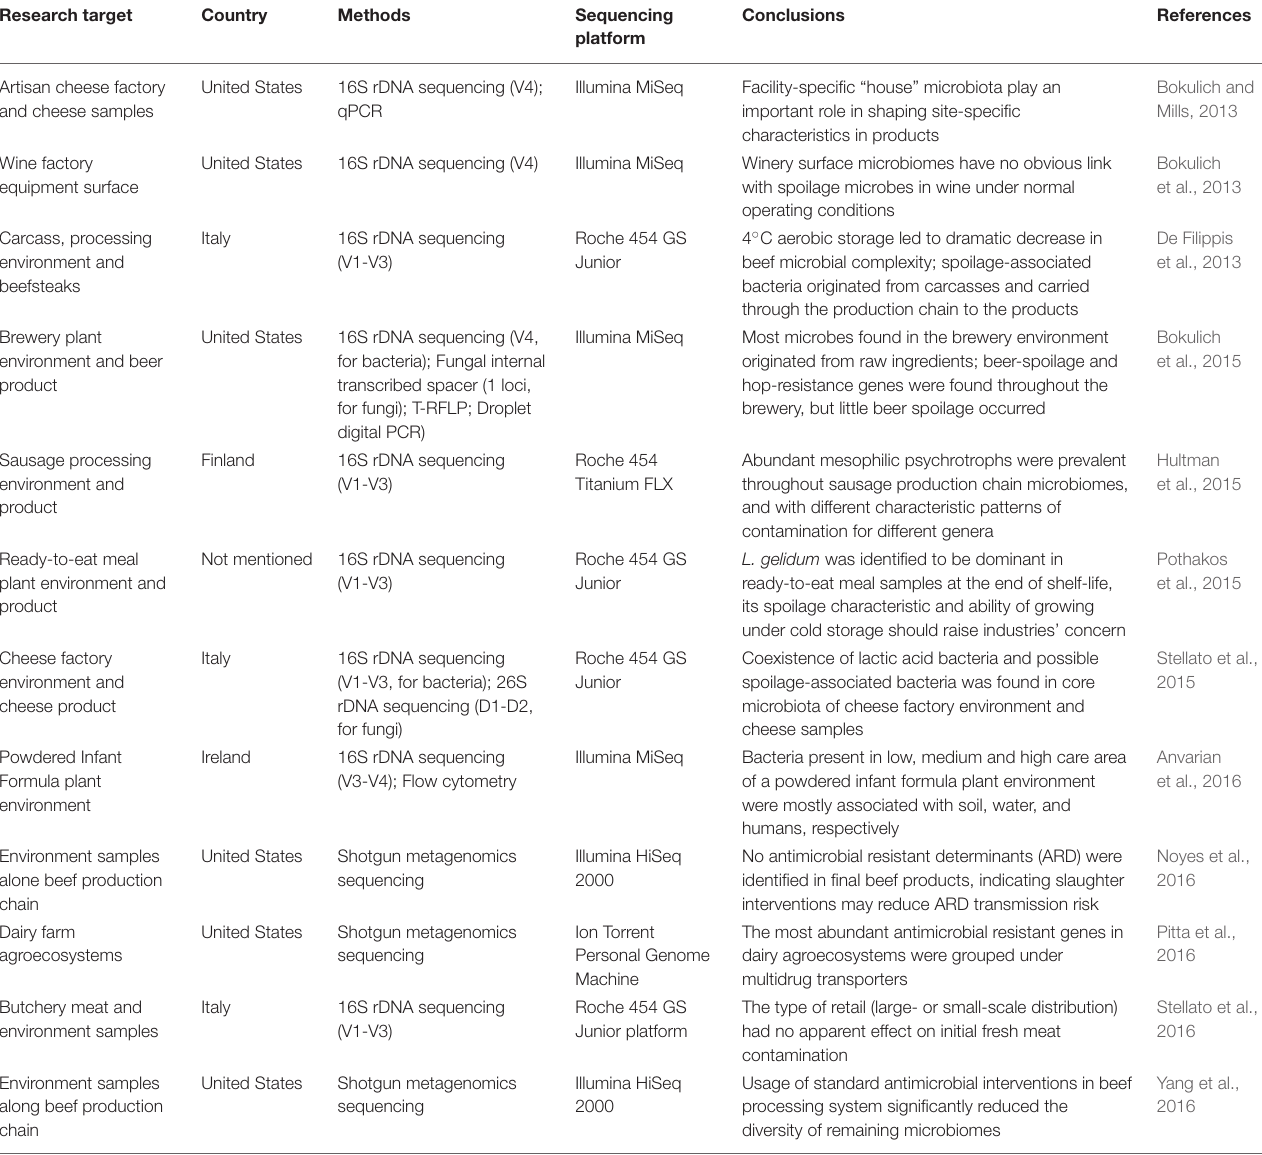
TABLE 1 | A comprehensive list of publications using next generations sequencing approaches to study the environmental microbiome along the food production